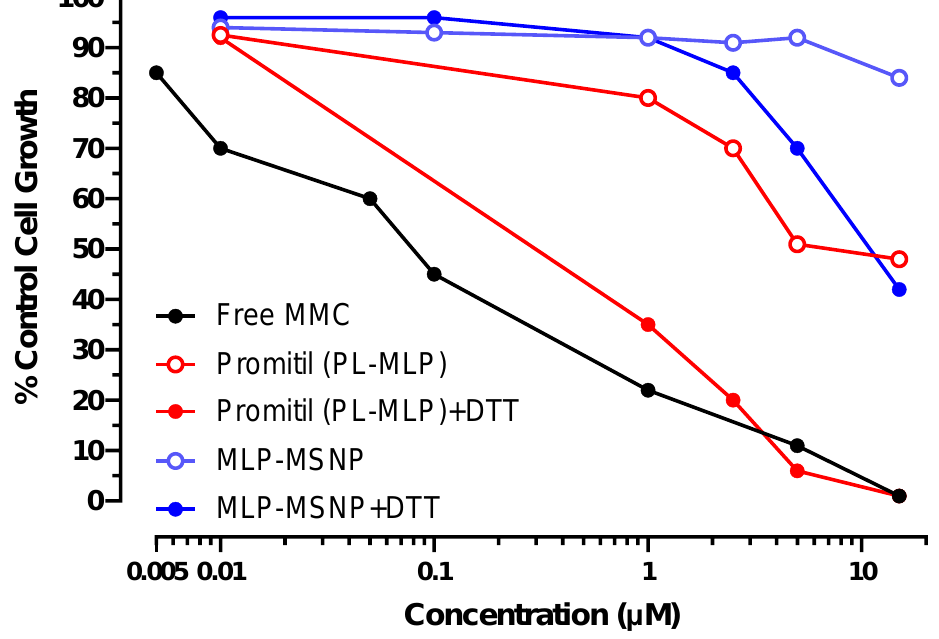
Figure 7. Cytotoxicity evaluation of N87 cancer cells exposed to different concentrations of free MMC, Promitil (MLP-loaded liposomes) dispersed in medium ± DTT (0.5 mM), and MLP-loaded MSNPs dispersed in medium ± DTT (0.5 mM).